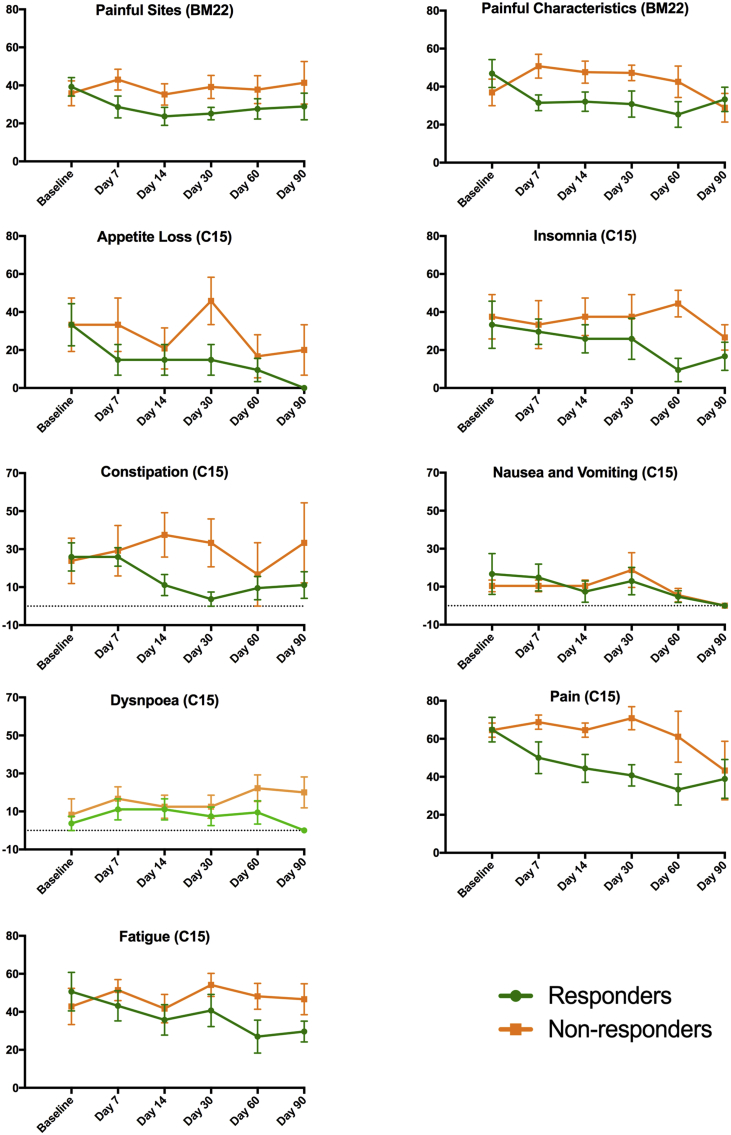
Graphs representing changes between responders and non-responders in each QLQ-BM22 and QLQ-C15-PAL symptom scale over time. The vertical axis is the mean score and the horizontal axis is the study time point. Error bars show standard error of the mean (SEM). Lower scores represent diminished symptoms, i.e. increased quality of life.